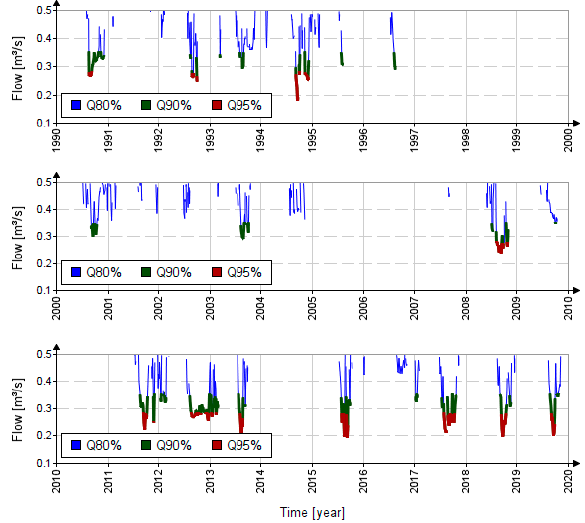
Figure 5. Water deficit graph for the Prigor River for the WMO reference period. The deficit volumes calculated for the thresholds of 95% are presented in Table 5. The analysis was also conducted for other thresholds, such as 90% and 80%. Table 5. The annual volume deficit.